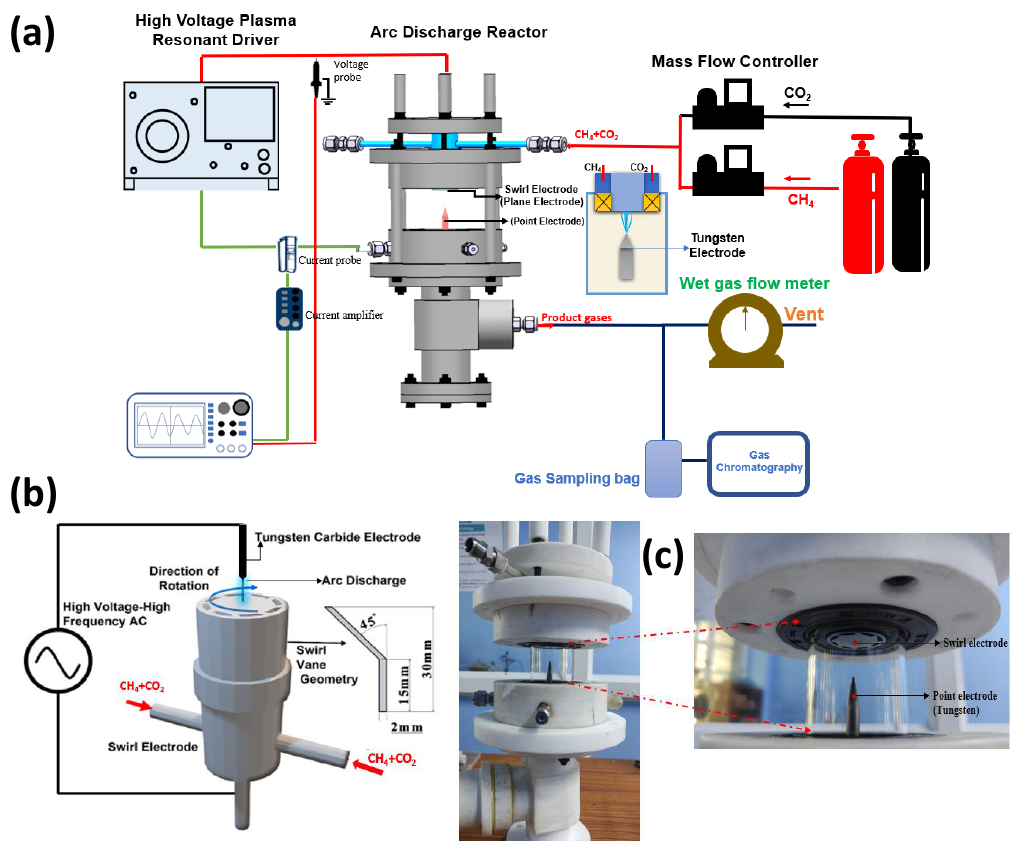
Figure 1. ( a ) Schematic of the experimental setup. ( b ) Schematic of the point-plane electrode. ( c ) Snapshots of the setup and the point-plane electrodes. Table 2. Details of the equipments and analytical facilies used in this study.